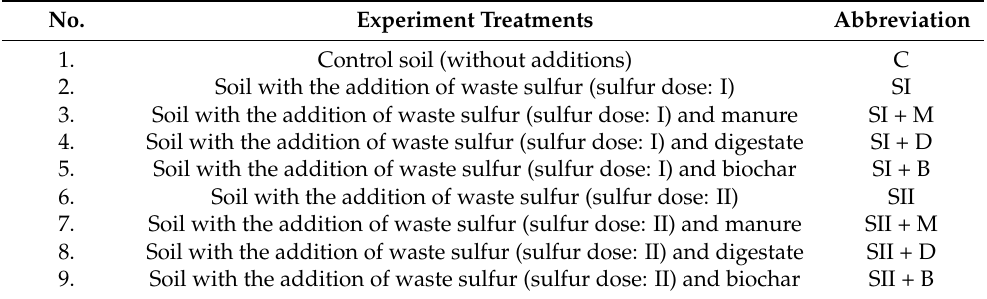
Table 2. Treatments conducted as part of the